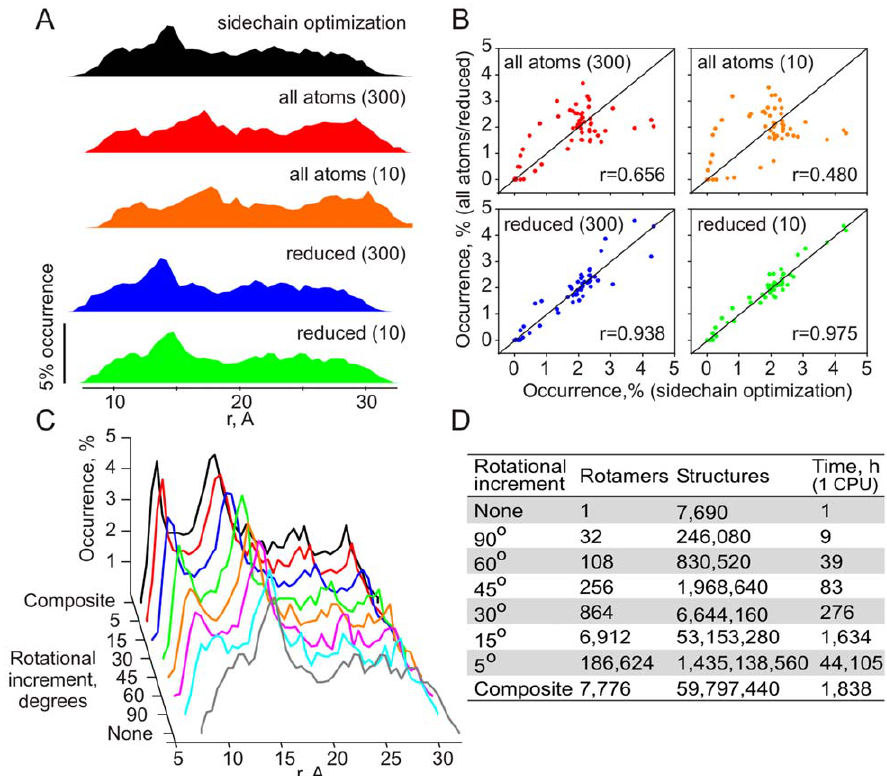
Figure 2. Conformational sampling in the Cc-Cb 5 complex. (A) Distribution of the heme-heme distances in the simulation runs with the full vdW potential and side-chain optimization (black); full vdW potential without side-chain optimization (vdW cut-off values of 300 kcal/mol and 10 kcal/mol; red and orange, respectively); and reduced vdW term, set to zero for all atoms extending beyond C b (vdW cut-off values 300 kcal/mol and 10 kcal/mol; blue and green, respectively). In these runs, only translational degrees of freedom of Cc were simulated. (B) Correlation plots of heme-heme distance occurrences in the side-chain optimization run (horizontal axis) and the other control runs (vertical axis), color-coded as in (A). Pearson correlation coefficients are indicated in the plots. (C) Distribution of the heme-heme distances in the runs with the reduced vdW term (vdW cut-off 10 kcal/mol, green dataset in A) and a given rotational increment ( dx = dy = dj , 0 u # x , y , 360 u , 0 u # j , 180 u ). For the composite run, dx = dy =5 u , dj =15 u ; 2 45 u # x , y # 45 u , 0 u # j , 360 u . (D) Number of rotamers for each Cc CM, the total number of structures sampled per run, and the total run time (for 1 CPU). each translation step. The ET distance distribution in this run (black profile in Figure 2A) was used as a reference for evaluating the protocols without side-chain optimization and the full vdW potential (vdW cut-off values of 300 kcal/mol and 10 kcal/mol; red and orange, respectively in Figure 2A,B) or a reduced vdW term, set to zero for all atoms extending beyond C b (vdW cut-off values 300 kcal/mol and 10 kcal/mol; blue and green, respec- tively in Figure 2A,B). As can be seen in Figure 2A, the red and orange profiles are shifted towards higher r values, indicating that the rigid-body simulations with the full vdW potential produce binding geometries with unrealistically large separations between protein molecules. This is further evidenced by poor correlations between the corresponding distance distributions (top plots in Figure 2B). The runs with the reduced vdW term (blue and green in Figure 2A) exhibit profiles highly similar to that of the reference run and feature greatly improved linear trends in the correlation plots (bottom graphs in Figure 2B). In particular, an excellent agreement between the results of the reference run and the computationally faster simulation protocol with the reduced vdW potential and the cut-off value of 10 kcal/mol (green datasets in Figure 2A,B) indicates that the latter produces reasonable rigid- body models of protein complexes. Therefore, this protocol was used in all subsequent simulations.